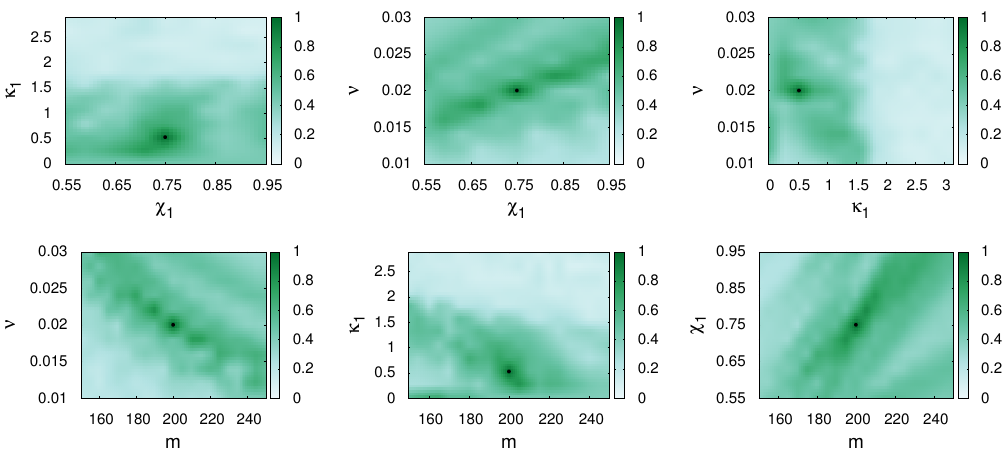
Figure 3. SpinDominatedWf is matched with itself and match values M are presented in different parameter planes ( κ 1 , χ 1 ), ( ν , χ 1 ), ( ν , κ 1 ), ( ν , m ), ( κ 1 , m ) and ( χ 1 , m ). The parameters of the first waveform (the template) are varied, while those of the second waveform (the signal, represented by a dot) are fixed as m = 200 M (cid:12) , ν = 0.02, χ = 0.75 and κ 1 = 0.5. The other parameters were chosen as f low = 10 Hz, ι = 0.5. Spins are precessing in this case.